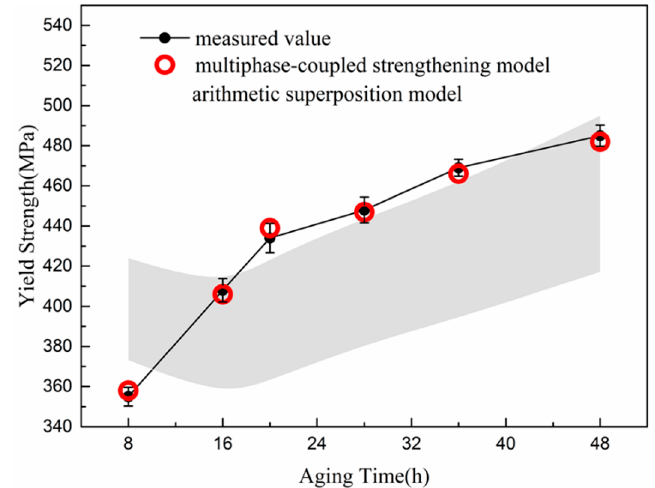
Figure 5. Experimentally measured yield strength during aging treatment at 170 °C and predictions by the multiphase-coupled strengthening model and the arithmetic superposition model.